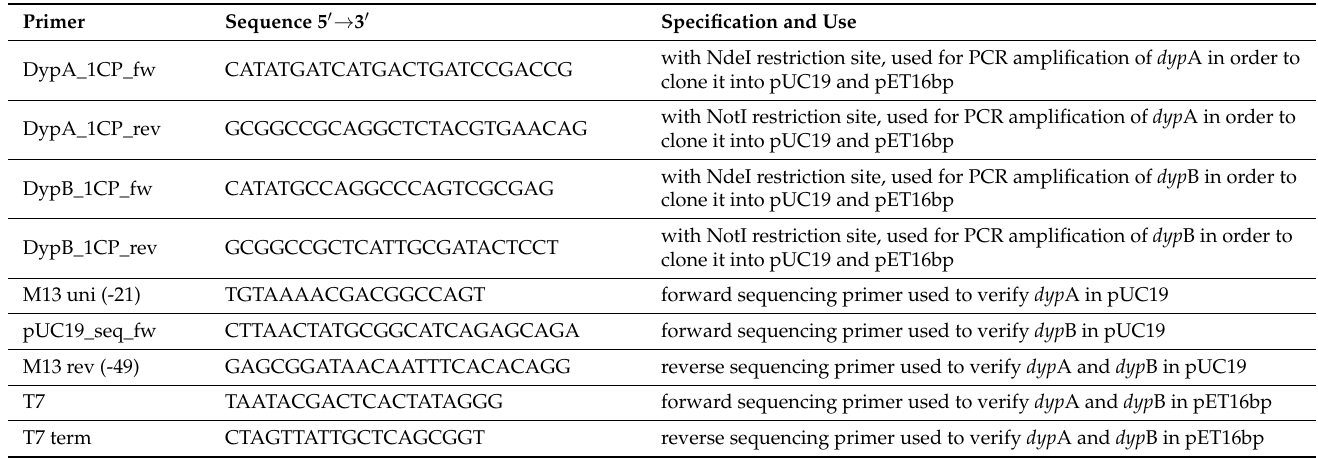
Table A3. Primers used for PCR amplification and